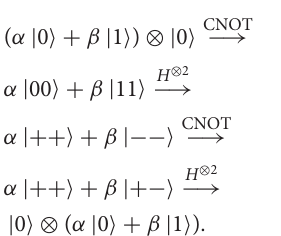
FIGURE 3 | Proposal for fully counterfactual general input CNOT gate based on a dual CQZE. (A) , Alice sends a photon in the qubit state α Bob’s quantum object QO B is in the qubit state λ PBS L , which are then, respectively fed into the H -input and V -input CQZE modules from Figure 2 . (B) , For Alice’s exiting photon, PBS L is replaced by a